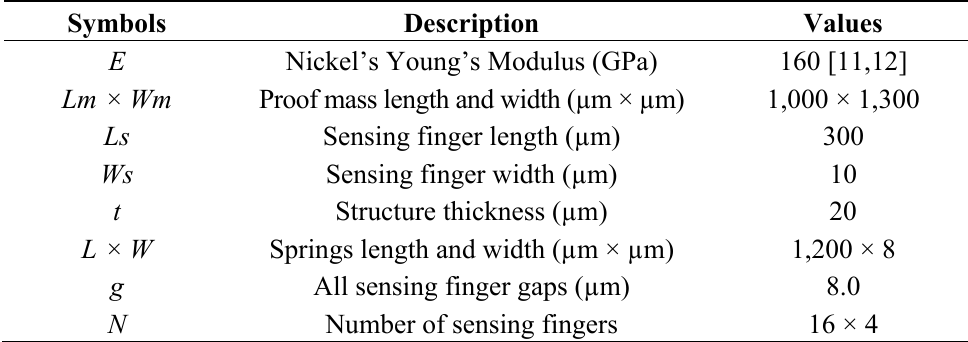
Table 2. Geometric and material properties.